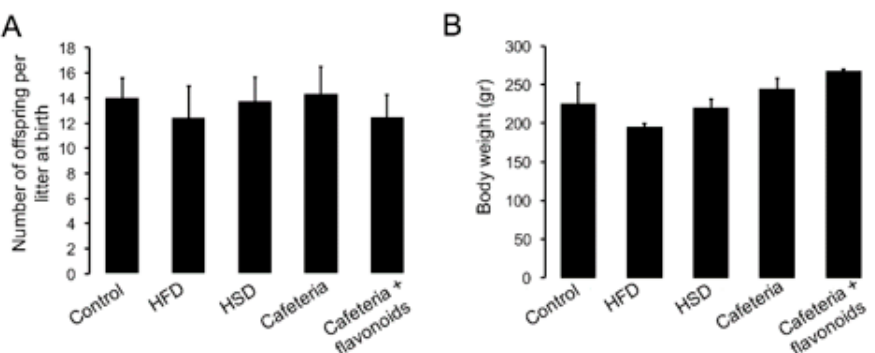
Figure 2. Effect of nutritional programming on birth and body weight in offspring. Diet exposure during pregnancy and lactation was performed as described. ( A ) Number of offspring (males and females) per litter at birth between diet exposure groups and standard chow diet. ( B ) Body weight chance was determined every week and expressed in grams. Graphs show mean ± SD.